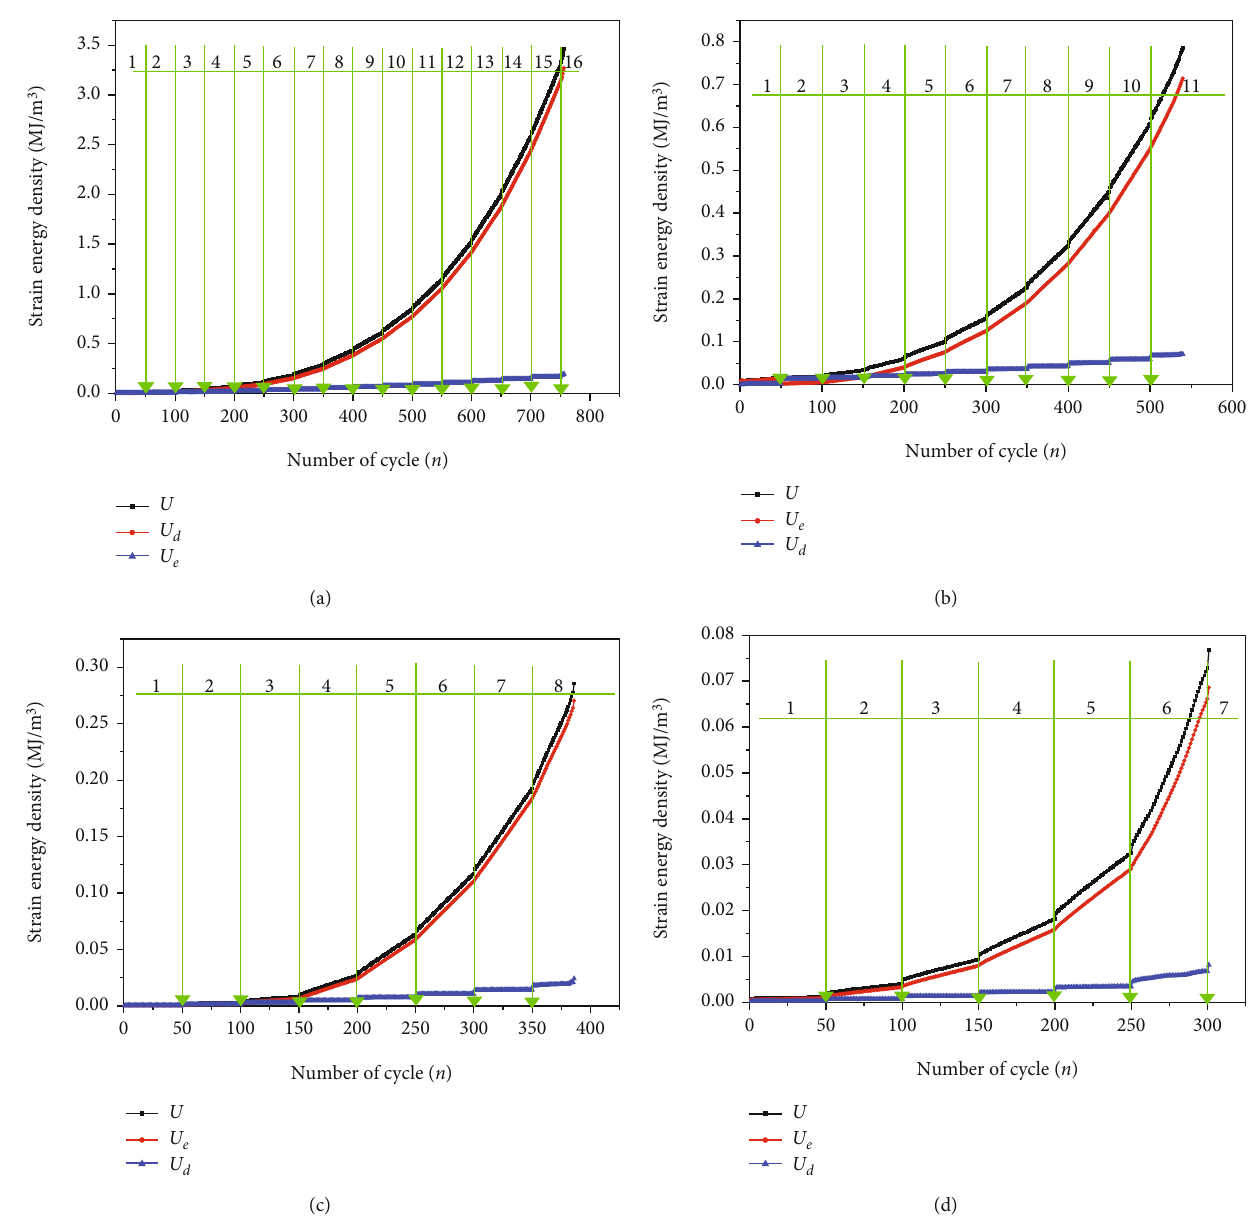
Figure 5: Energyevolutionduringrockdeformation((a –